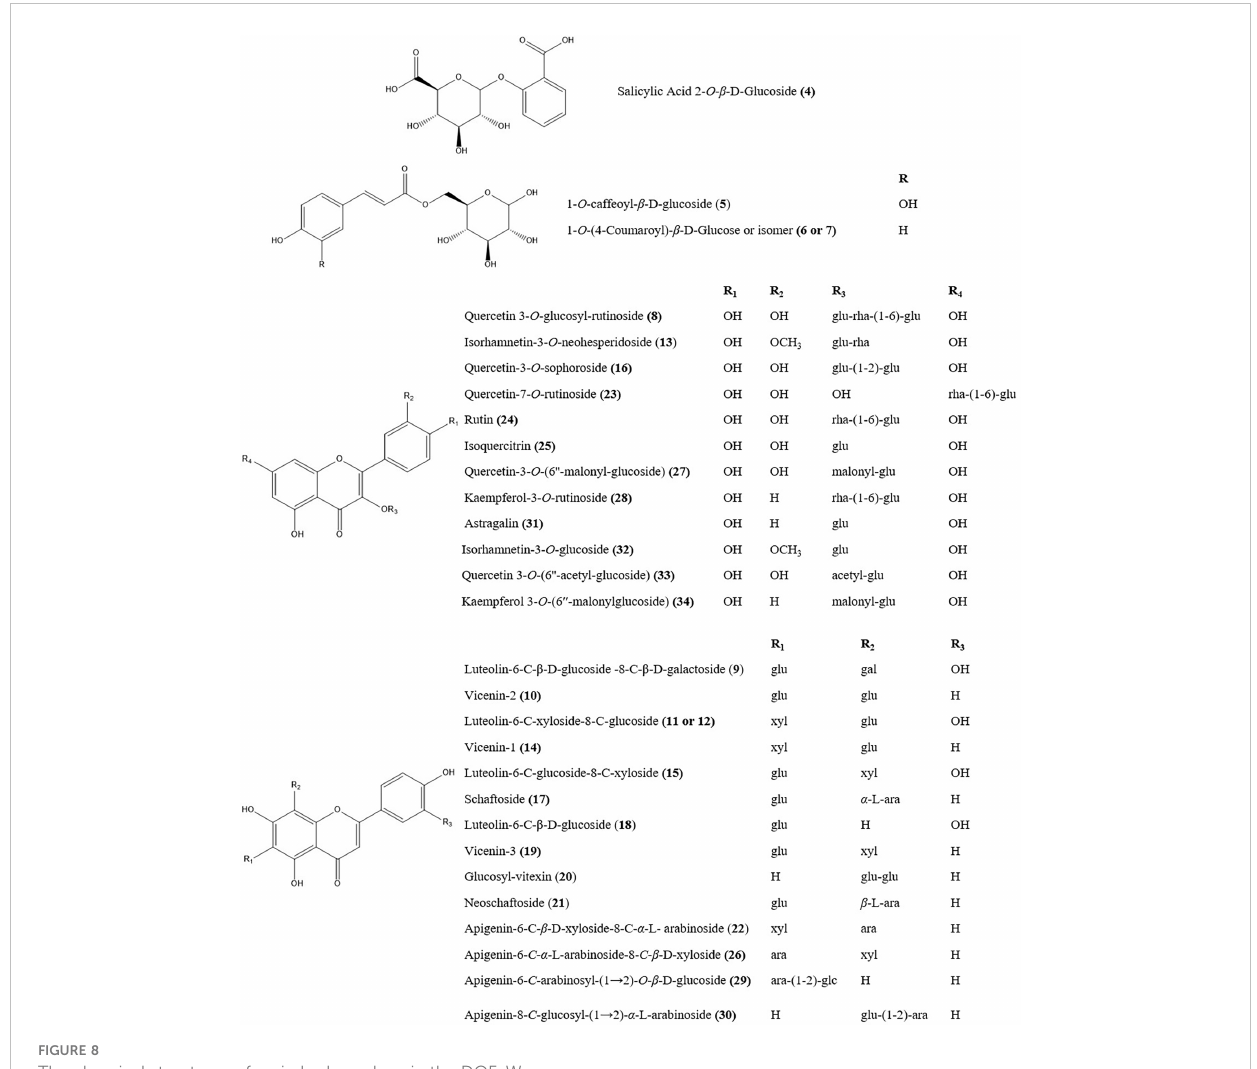
FIGURE 8 The chemical structures of main herb markers in the